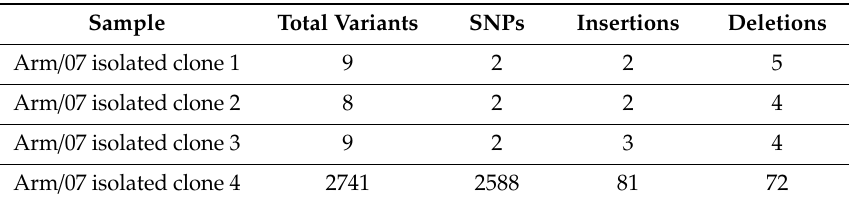
Table 4. Variant analysis of DNA samples of ASFV clones isolated from the Arm / 07 stock compared to Georgia 2007 / 1 genome.